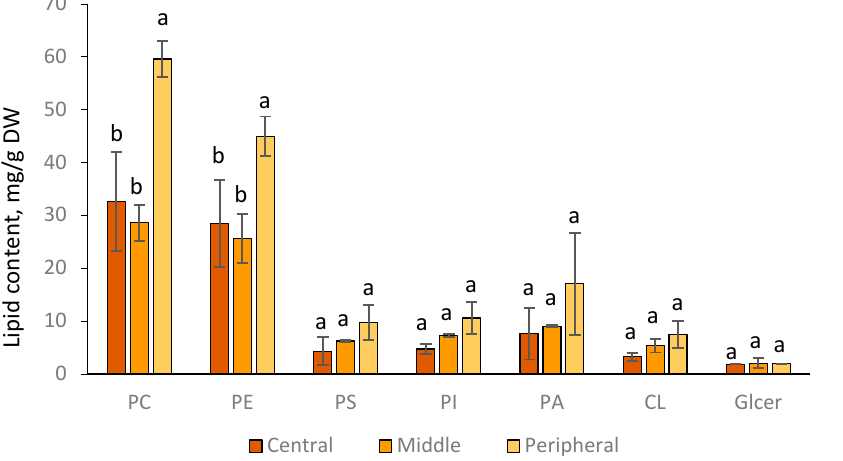
Figure 2. The composition of lipid classes in different zones of the F. velutipes colony. The experiments were performed in triplicate, and error bars indicate standard deviations. Different letters above the bars indicate statistically significant differences at p -value < 0.05 ( t -test). PC – phosphatidylcholine;